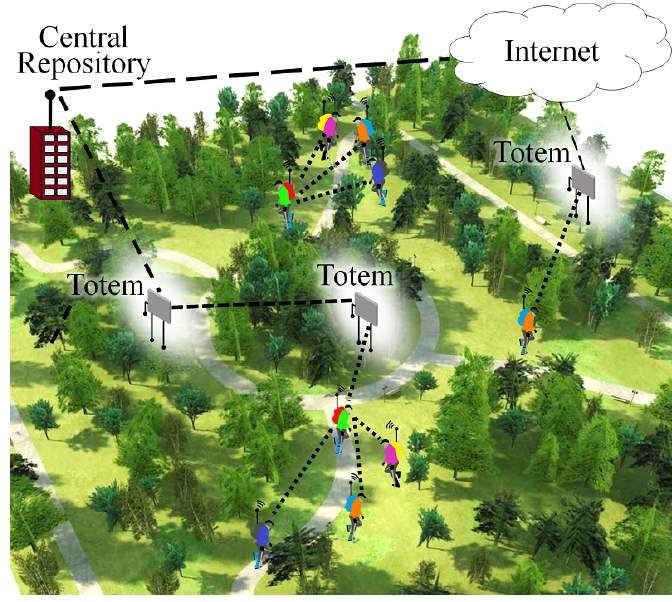
Figure 6. Network